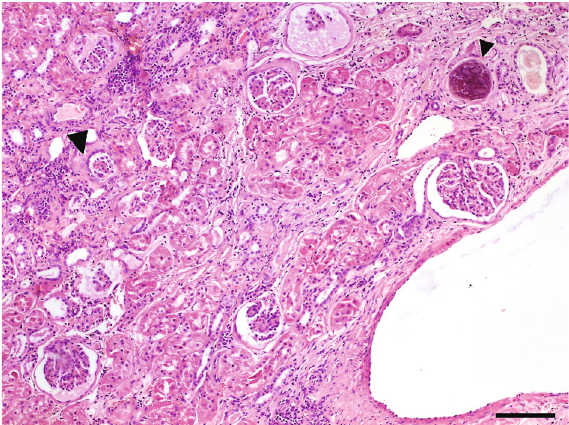
Figure 6: Histological aspect of renal parenchyma of 8-year-old mixed-breed dog with ectopic ureter: note the characteristic dysplastic aspect of the kidney, with loss of corticomedullary di ff erentiation, containing some well-developed glomeruli, admixed to small cysts and primordial glomeruli (big arrow) surrounded with a cubic-to-cylindrical epithelium. Some glomeruli are calci fi ed (small arrow). H&E, scale bar = 300 μ m .